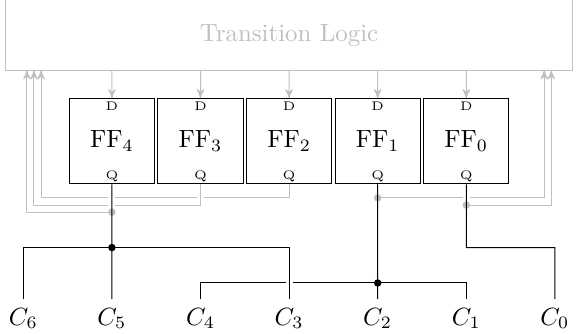
Figure 2: Exemplary constant generation from a state